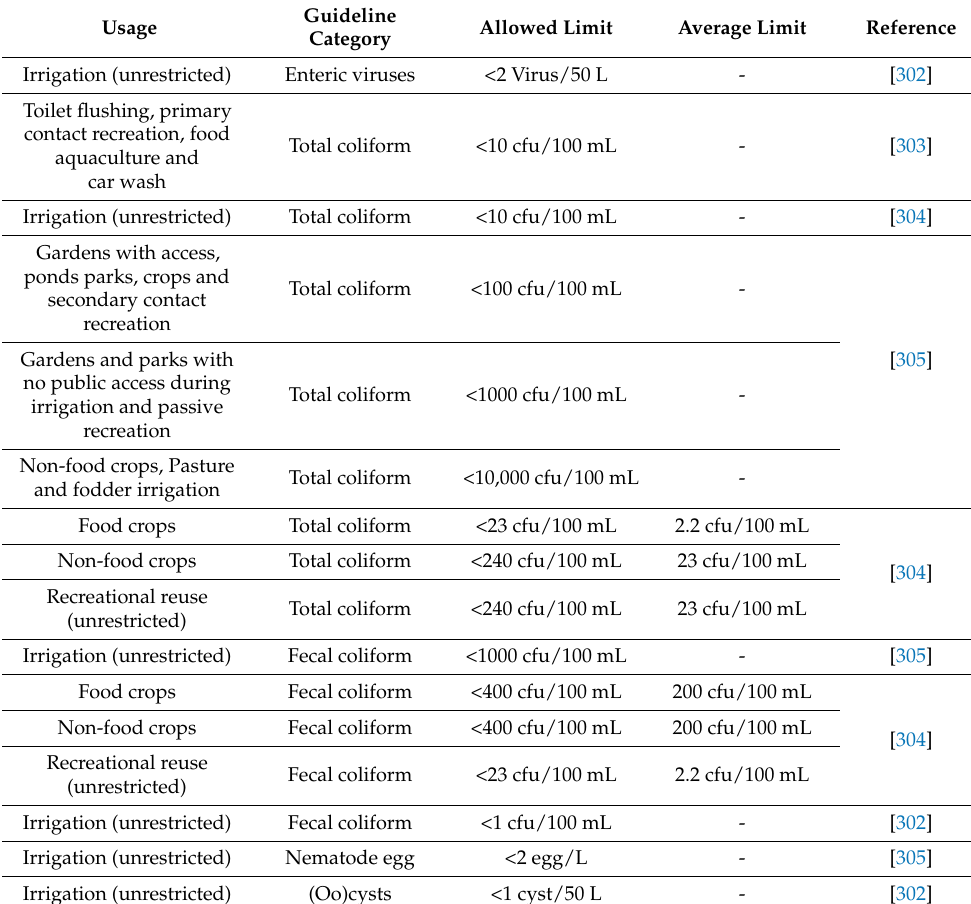
Table 7. Microbial guidelines for wastewater